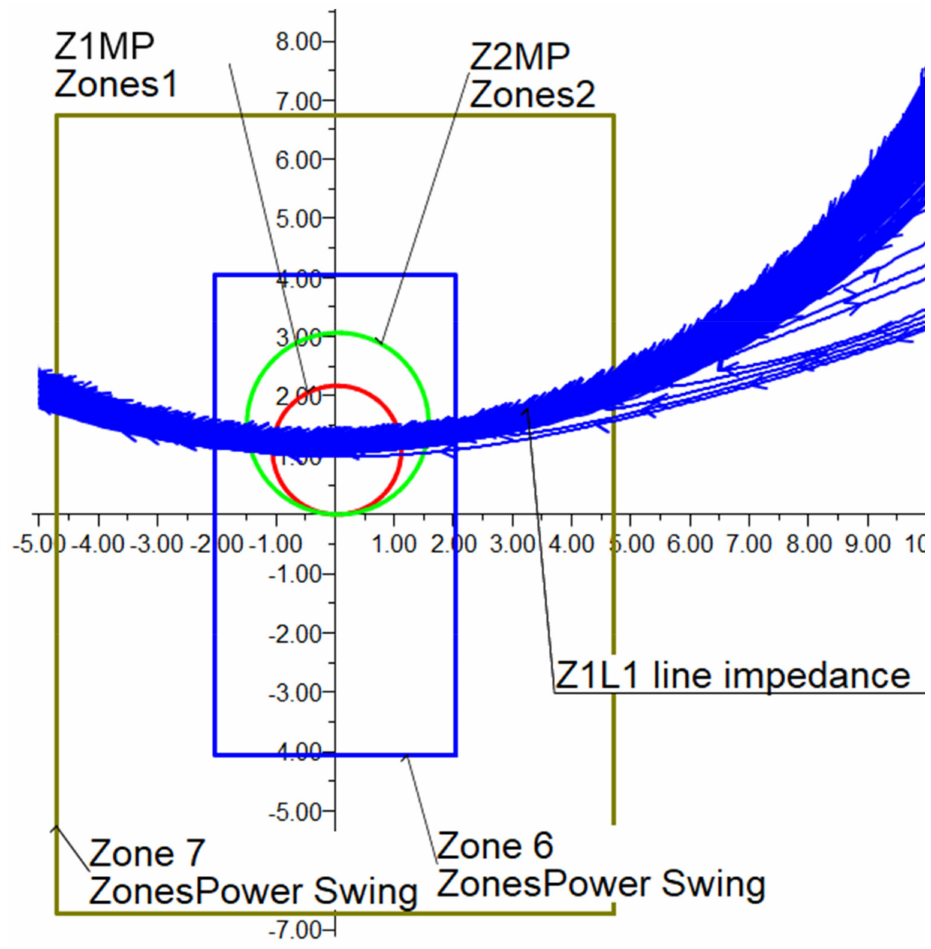
Figure 16. Test 1 : R-X plot without OOS protection on CCT-1